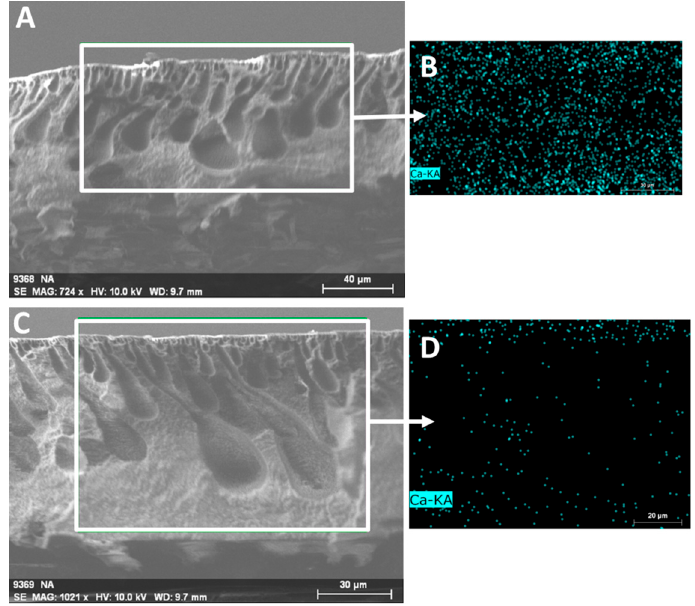
Figure 11. SEM imaging and EDS mapping (Ca) of N-SPVDF-PAA membrane cross section (PVDF layer only). ( A ) and ( B ) are N-SPVDF-PAA after Ca 2+ ion-exchange (200 mg/L feed solution) in batch mode, while ( C ) and ( D ) are pristine N-SPVDF-PAA directly following PAA functionalization.